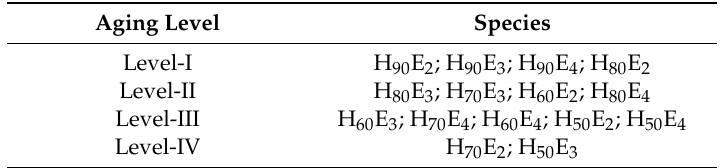
Table 5. UV aging test